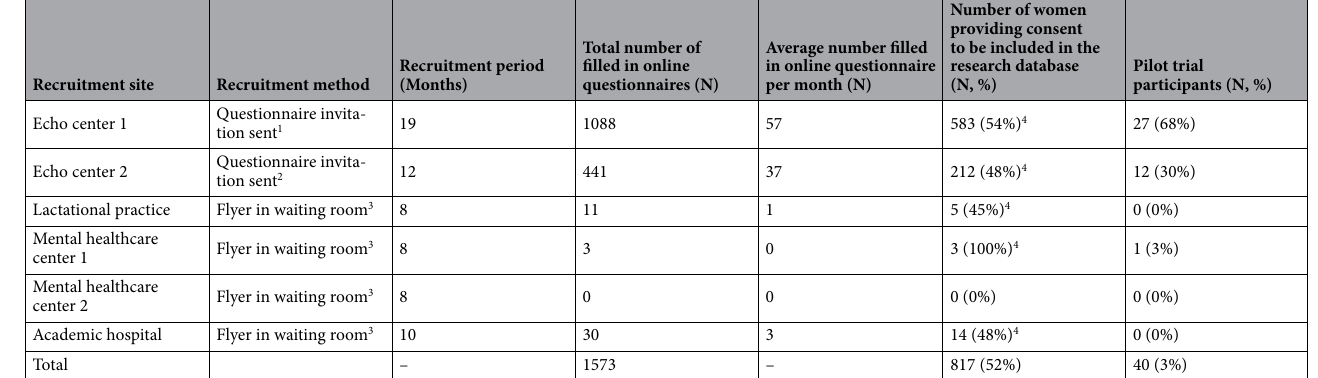
Table 3. Recruitment method, recruitment period, number of potential participants who filled in the online questionnaire, average number of filled in online questionnaires per month, number of potential participants providing consent to be included in the research database rate, and number of included participants per recruitment site. 1 The online questionnaire invitation was sent to potential participants 3 weeks after the 20-week ultrasound. 2 When women visited echo centre 2 for their 20-week ultrasound, personal email addresses were collected; 3 weeks thereafter the online questionnaire invitation was sent per email. 3 Flyer with link to online questionnaire was located in the waiting room. 4 Percentage of total number of filled in online questionnaires per recruitment site.